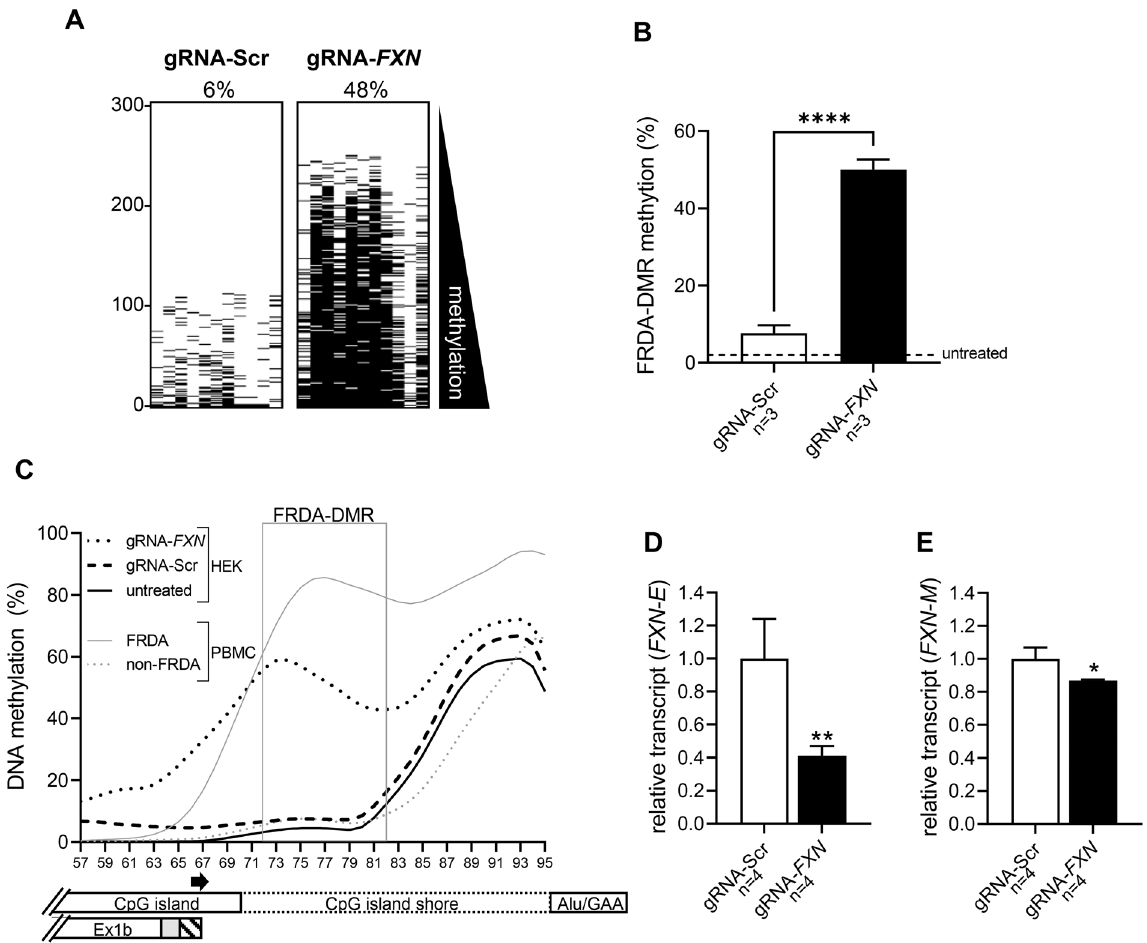
Figure 7. DNA hypermethylation of the FRDA-DMR silences FXN-E . ( A ) FRDA-DMR methylation assayed as a single amplicon to test each of the n = 11 CpG dinucleotides in cis displayed as n = 300 sequencing reads stacked vertically for HEK293T cells transfected with dCas9-DNMT3A targeted to intron 1 of FXN via a guide RNA (gRNA- FXN ) or with a scramble guide used as a negative control (gRNA-Scr). Black dash = methylated CpG; reads are sorted with highest methylation at the bottom and percent methylation in the FRDA-DMR is displayed above the respective panels. ( B ) FRDA-DMR methylation (mean ± SD) for n = 3 experiments (**** p < 0.0001, t = 21.78, df = 4). FRDA-DMR methylation for untreated HEK293T cells is shown as a dashed line for comparison. ( C ) DNA methylation is plotted as a percentage of 1000 sequencing reads, at each of 39 CpG dinucleotides (numbered 57–95) that map between the 3 ′ end of the CpG island and the Alu repeat element that contains the expanded GAA repeat. Data are displayed as LOWESS trendlines for HEK293T cells either untreated or treated with dCas9-DNMT3A+ gRNA- FXN (to target the FRDA-DMR) or dCas9- DNMT3A+ gRNA-Scr (negative/scramble control). Non-FRDA and FRDA PBMCs are shown for comparison. The FRDA-DMR is outlined with a gray box, and the relative locations of the CpG island, CpG island shore, Alu/ GAA, and Ex1b are indicated. The location of the gRNA is indicated by the rightward pointing arrow alongside the X-axis. ( D ) Relative FXN-E transcript levels and ( E ) Relative FXN-M transcript levels for n = 4 transfections with either dCas9-DNMT3A + gRNA- FXN (to target the FRDA-DMR; black bars) or dCas9-DNMT3A+ gRNA- Scr (negative/scramble control; white bars). Transcript levels are shown as mean ± SD; Two-tailed, unpaired t test; for FXN-E : p = 0.0038, t = 4.579, df = 6, and for FXN-M : p = 0.0106, t = 3.656, df = 6. Note: despite the statistical significance of FXN-M , the magnitude of change is not considered biologically significant, and FXN-M was not significantly altered in another independent experiment (see Fig.